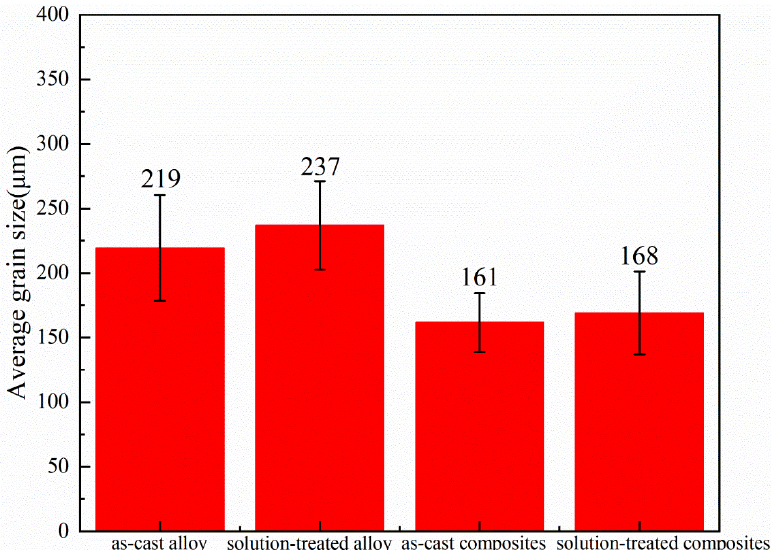
Figure 11. Average grain size of the alloys and the composites before and after solution treatment.